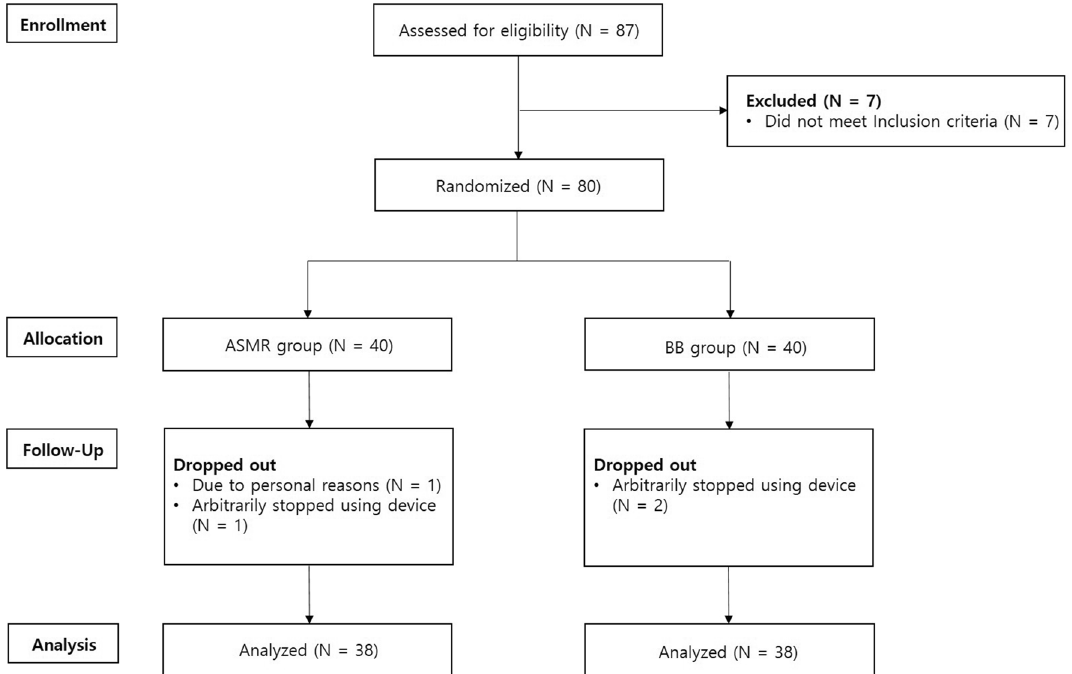
Figure 1. Flow chart summary of the participants. ASMR : Autonomous sensory meridian response, BB : Binaural